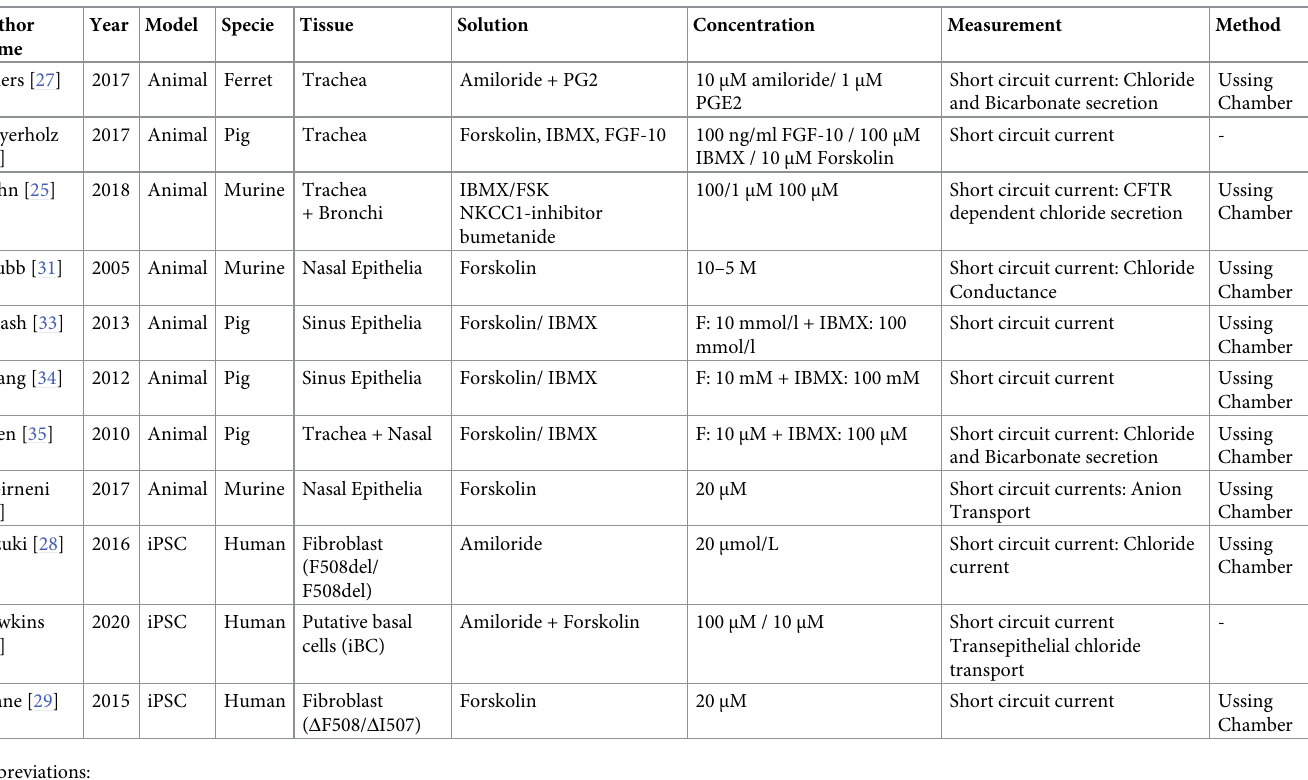
Table 1. Characteristics of included